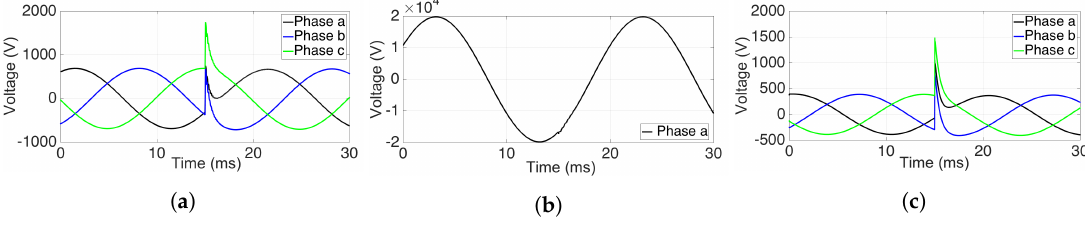
Figure 8. Impact of frequency-dependent cable on transient overvoltages. ( a ) LV side of the main transformer; ( b ) HV side of the main transformer from node to ground; ( c ) control circuits.